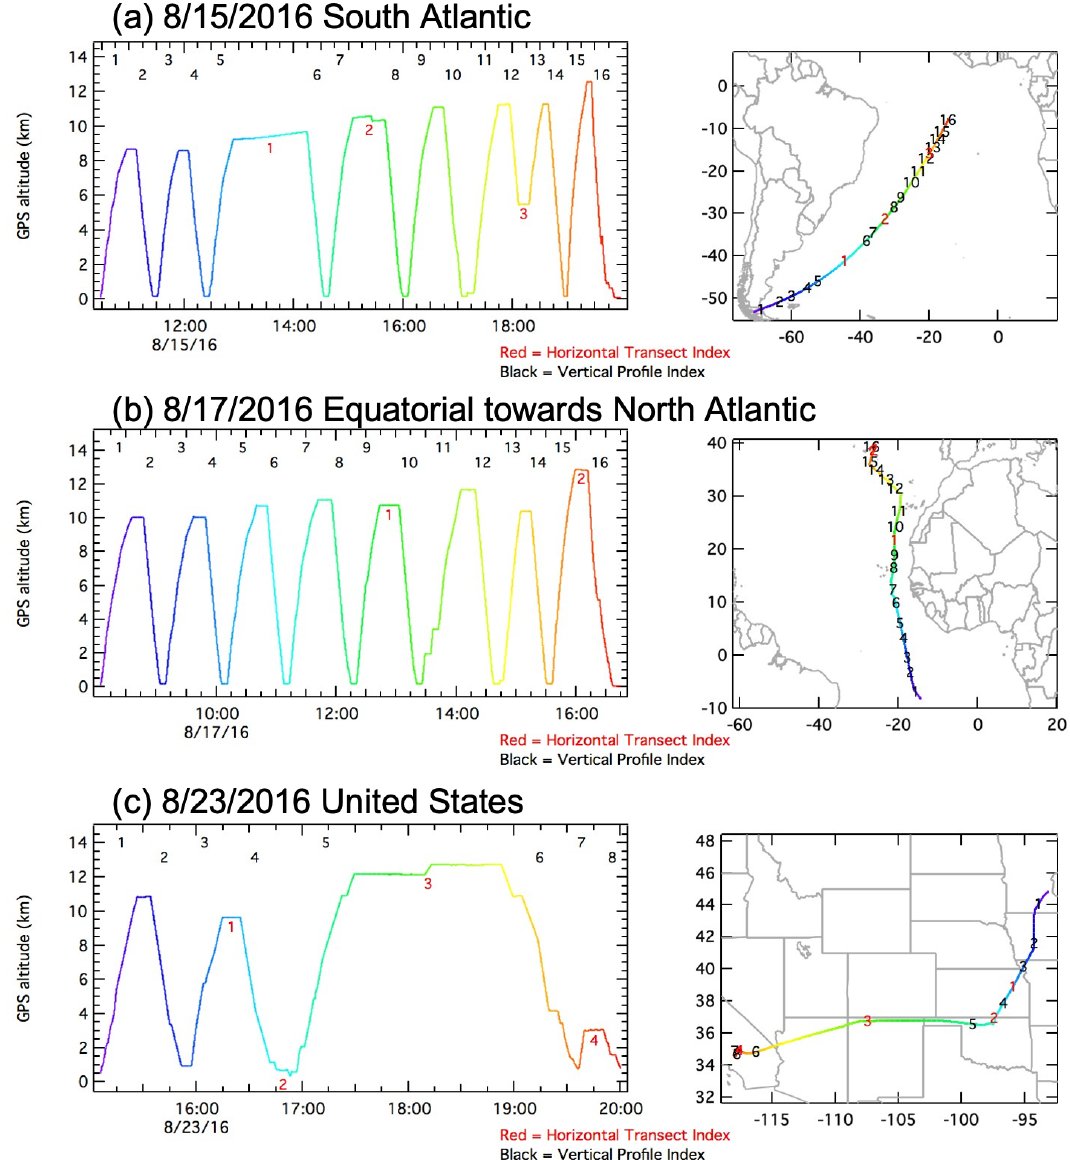
Figure 1. Vertical profiles and transect time series of the ATom-1 flight tracks on (a) 15 August over the South Atlantic, Punta Arenas to Ascension, (b) 17 August over the equatorial zone towards the North Atlantic, Ascension to Azores, and 23 August over the United States, Minnesota to southern California in 2016. Dates are indicated in mm/dd/yyyy